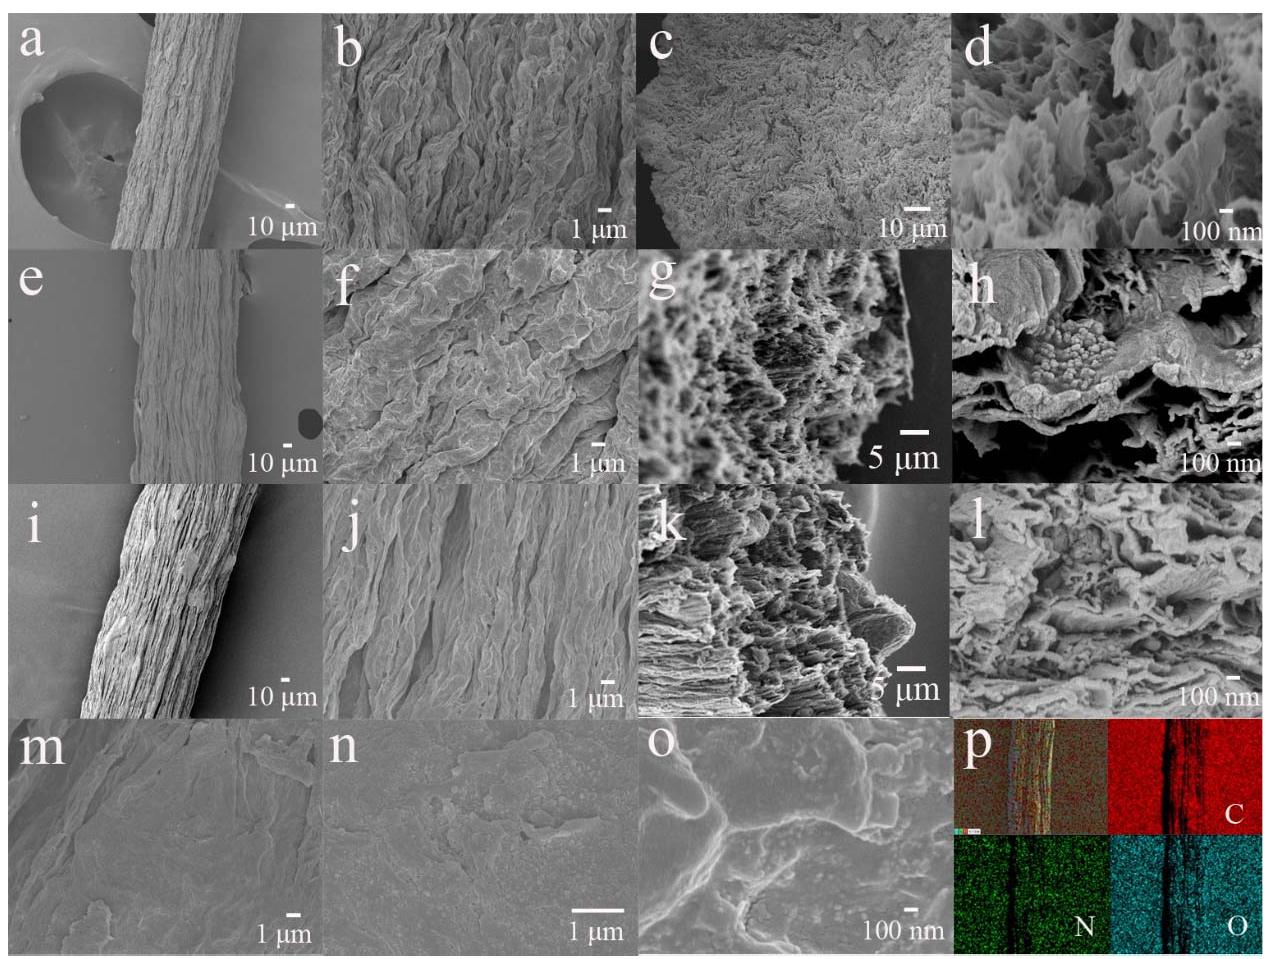
Figure 3. ( a , b ) Surface and ( c , d ) cross ‐ sectional SEM images of GF; ( e , f ) surface and ( g , h ) cross ‐ sectional SEM images of PANI/GF 1 ; ( i , j ) surface and ( k , l ) cross ‐ sectional SEM images of PANI/GF; ( m – o ) enlarged surface SEM images of PANI/GF; and ( p ) EDS mapping of C, O and N.